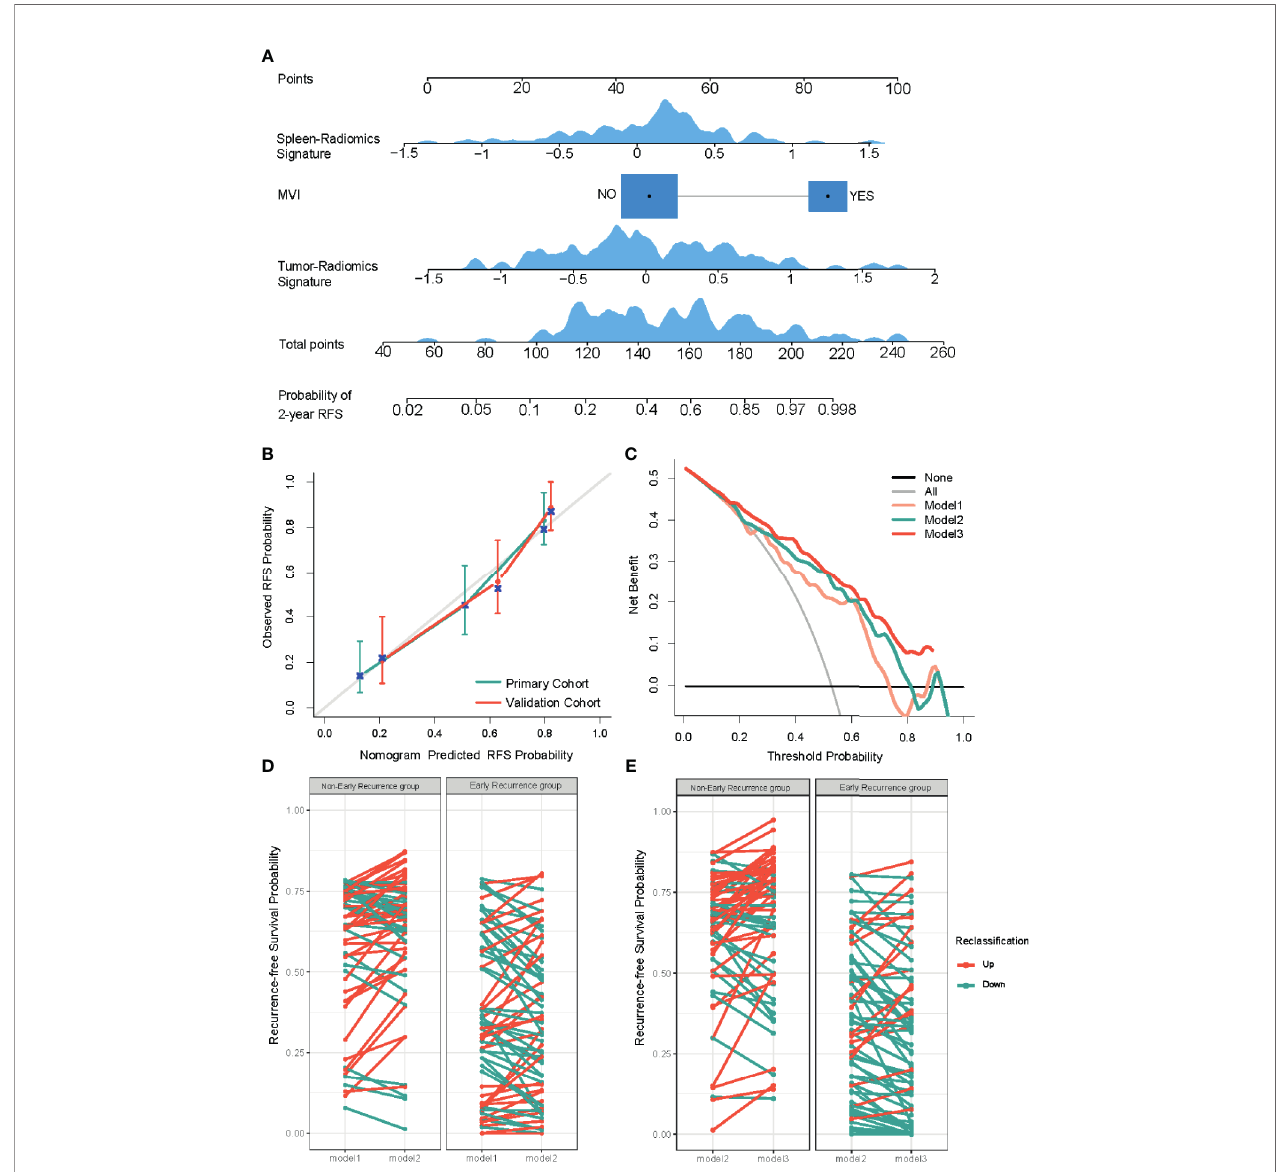
FIGURE 4 | Development and performance evaluation of nomogram for recurrence-free survival (RFS) evaluation of HCC early recurrence. (A) A radiomics nomogram was developed in the primary cohort, with spleen-radiomics signature, tumor-Radiomics Signature and microvascular invasion (MVI) incorporated. (B) Calibration curves to show the calibration of the radiomics nomogram in terms of the agreement between the predicted and the observed 2-year RFS in both primary and validation cohorts. (C) Decision curve analysis of clinical usefulness assessment of Model 3 in the primary cohort, the y-axis represents the net bene fi t, and the x-axis represents the threshold probability. Model 3 achieves more net bene fi t across the majority of the range of threshold probabilities compared with Model 1, Model 2, treat-all strategy (gray line), and treat-none strategy (horizontal black line). (D, E) Net reclassi fi cation improvement (NRI) analysis of models in the primary cohort. Potential incremental value of Model 2 relative to Model 1 (D) and Model 3 to Model 2 (E) were assessed by